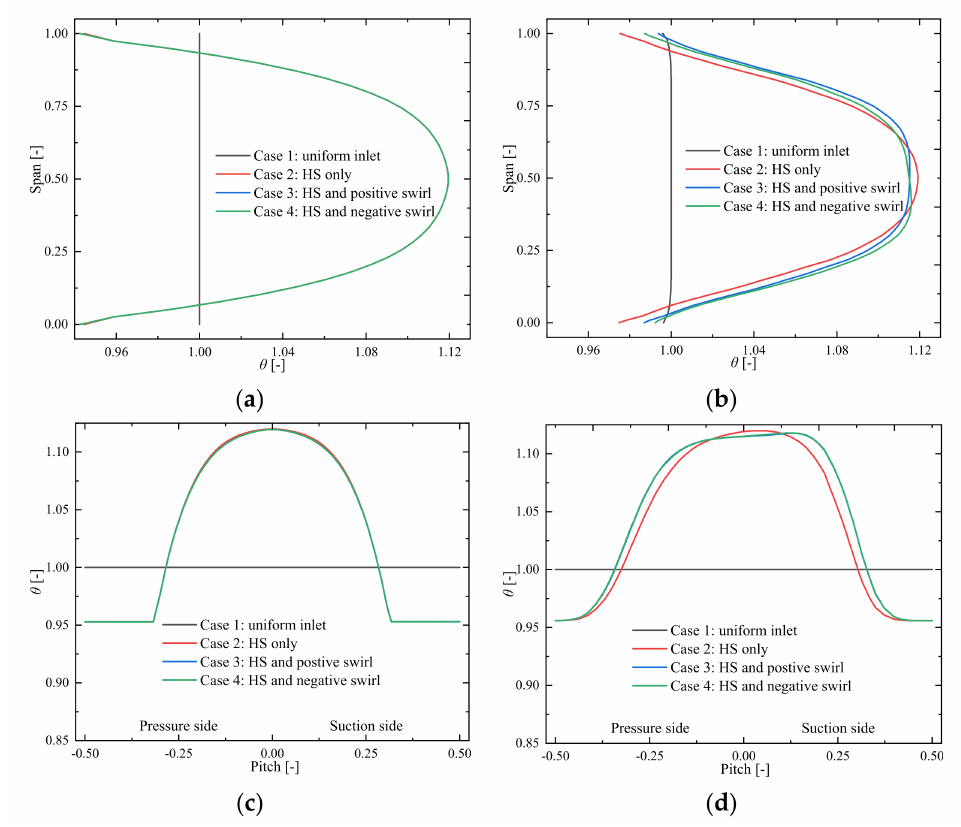
Figure 10. Local temperature profiles along the circumferential and radial directions. ( a ) Temperature profiles at the passage inlet; ( b ) Temperature profiles at the − 10% C ax plane; ( c ) Temperature profiles at the passage inlet; ( d ) Temperature profiles at the − 10% C ax